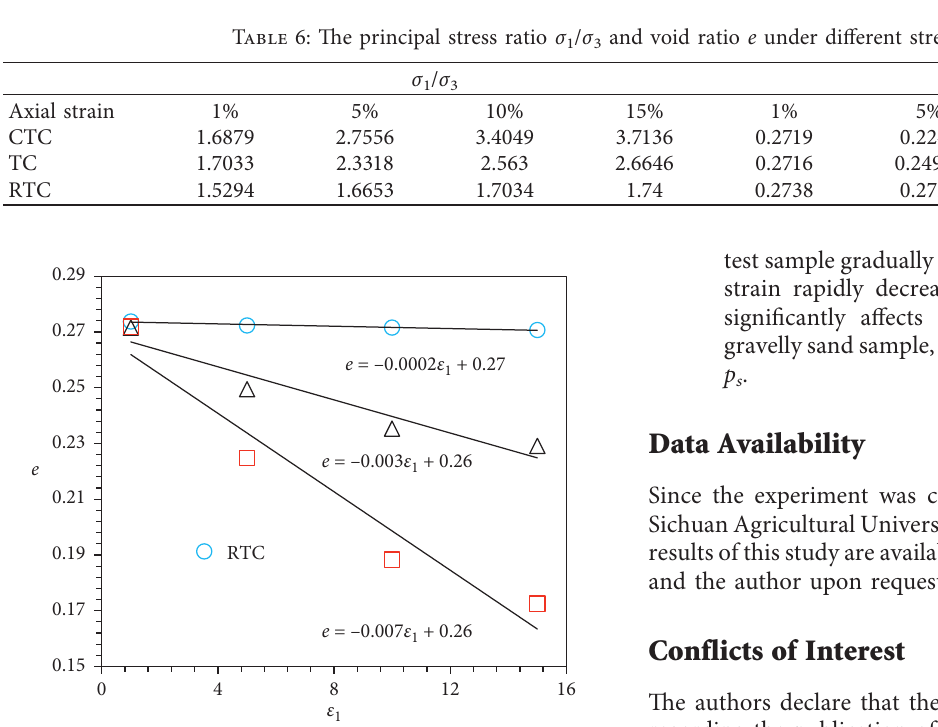
Figure 20: The relationship between void ratio e and stress